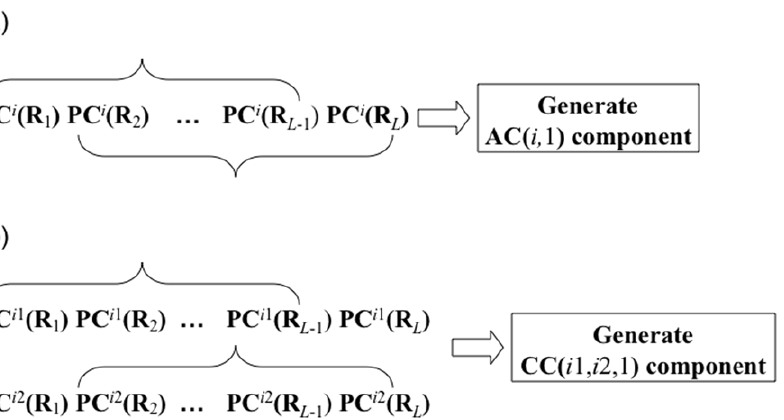
Figure 1. An illustration to show two types of covariance. ( a ) The auto-covariance refers to the coupling between two subsequences from a same sequence when they are separated by l ~ 1 unit. ( b ) The cross-covariance refers to the coupling between two subsequences from two different sequences as indicated by two open curly braces. doi:10.1371/journal.pone.0030869.g001 PLoS ONE |